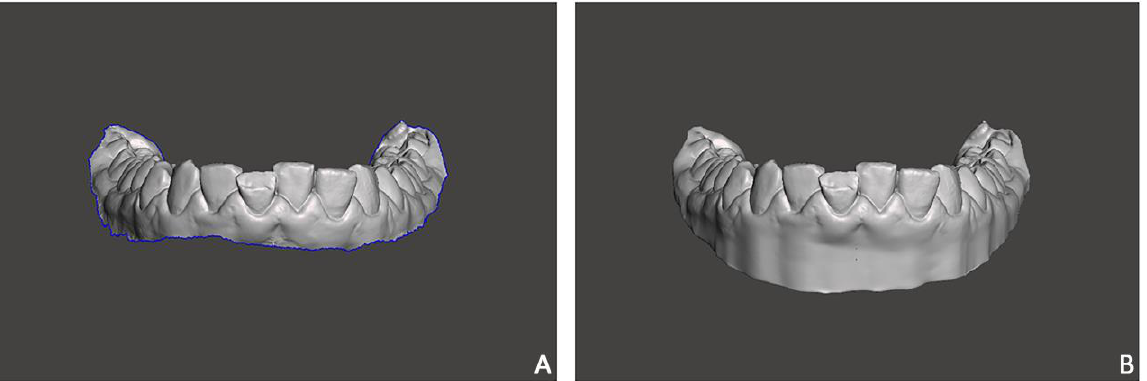
Figure 4. The triangular mesh of the model is modified into Mesh-Mixer (Autodesk, San Rafael, CA, USA) to allow further operations of detailing, analysis, or modelling of custom-made appliances. ( A ), Original model; ( B ), model with extruded base.